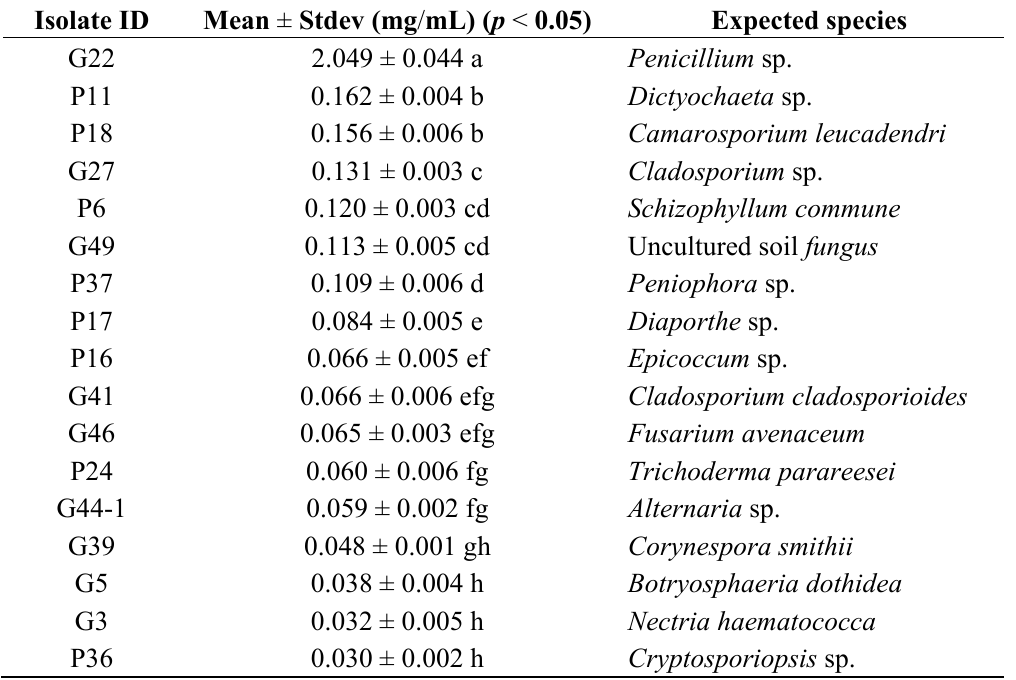
Table 2. Triterpenoid saponin production of the representative isolate from each group.